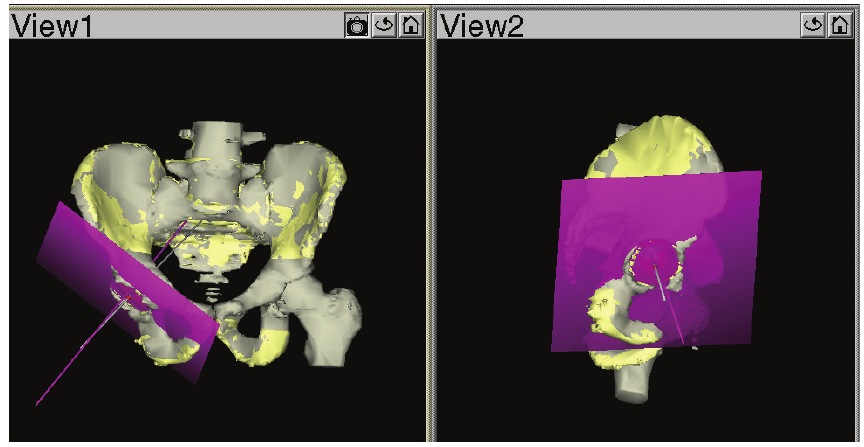
Figure 2: Example of a CT-scan validation process, where both models (pre- and postoperative) are superimposed to calculate the cup orientation based on the coordinate system defined